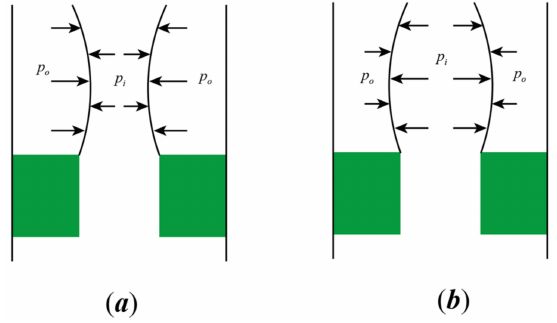
Figure 4. Diagram of the expansion